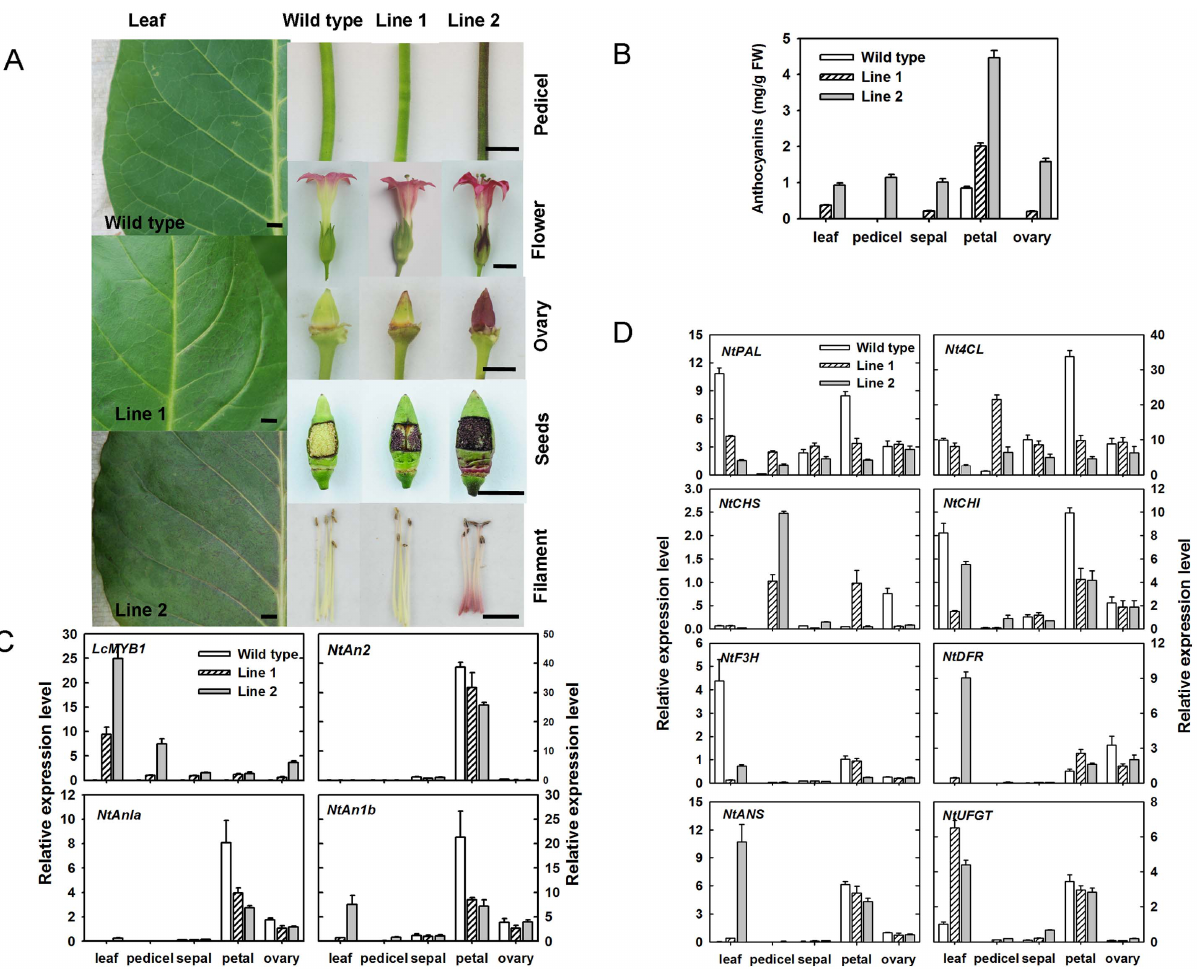
Figure 6. Images of the transgenic tobacco lines and the anthocyanin content, and the expression of anthocyanin biosynthetic pathway structural and regulatory genes in transgenic tobacco lines. A, Images of tobacco lines containing the empty vector (wild type) or the LcMYB1 allele with the CaMV 35S promoter (Line 1–2) (Scale bars for images=1cm. B, Anthocyanin content in different organs of transgenic tobacco lines. C, Regulatory gene expression in the anthocyanin biosynthetic pathway in transgenic tobacco. D, Structural gene expression in the anthocyanin biosynthetic pathway in transgenic tobacco lines. The Lcactin gene was used to normalize gene expression of the genes under identical conditions. The vertical bars represent the standard error of triplicate experiments.